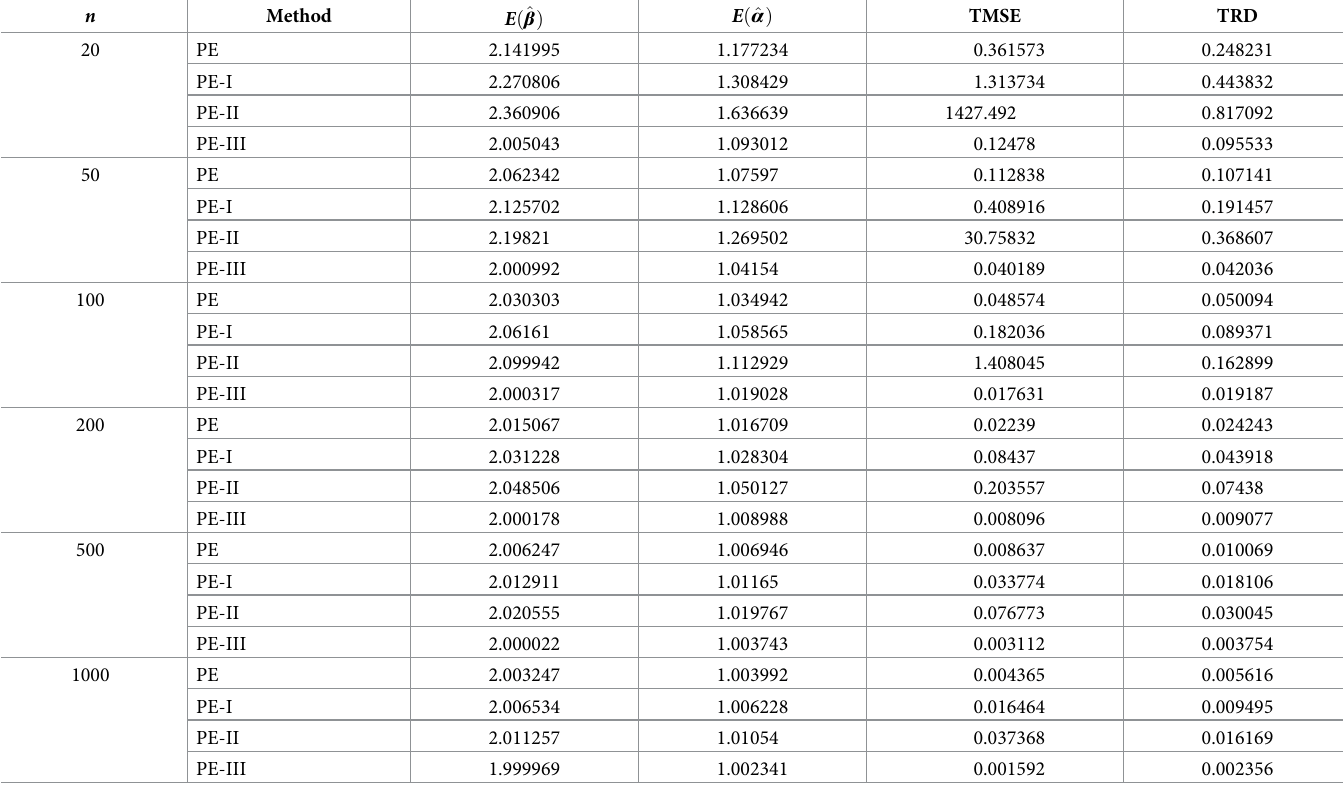
Table 4. Comparison of PE and modified PE for β = 2, α = 1.